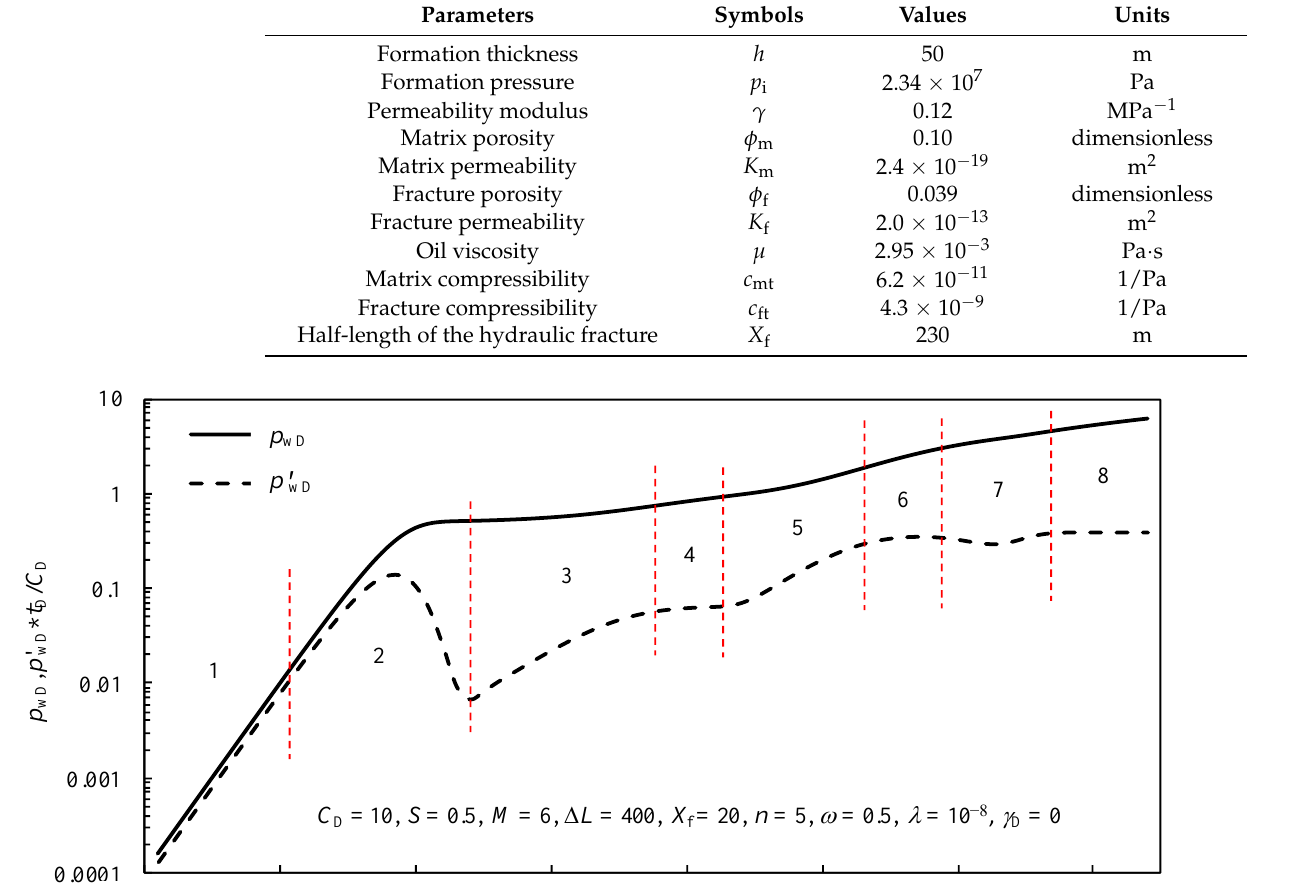
Table 2. Reservoir parameters needed for simulation.